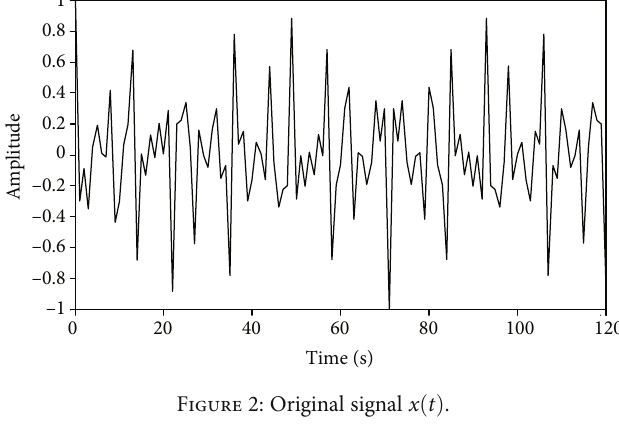
Figure 2: Original signal x ð t Þ .